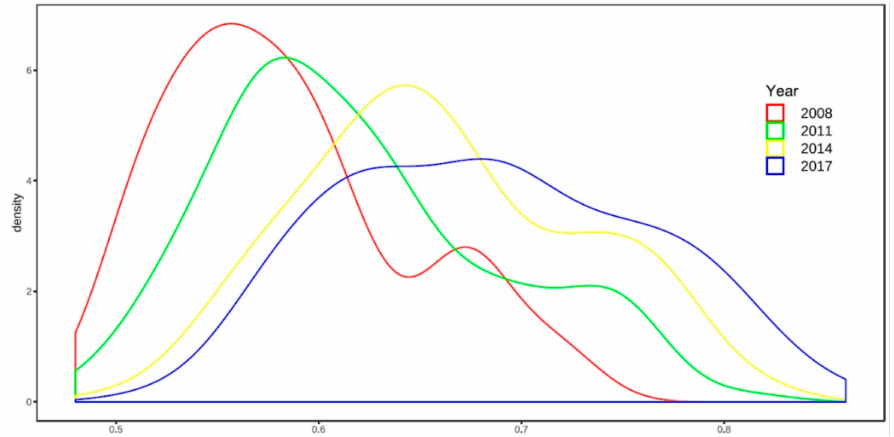
Figure 3. Estimated nuclear density for the level of urban green development in YREB (2008, 2011, 2014,